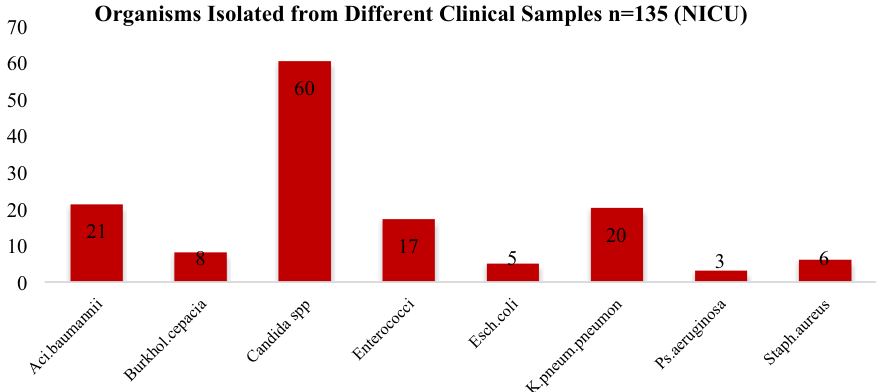
Figure 11. Spectrum of microorganisms isolated from clinical sample: Blood sample from NICU. Most common species identified from blood specimen of clinical samples shows the maximum presence of Candida spp. (60/135) followed by Acinetobacter baumanii (21/135), Klebsiella Pneumoniae (20/135) , Enterococci (12/135), Burkholderia cepacia complex (8/135), Staphylococcus aureus (6/135), E.coli (5/135), Pseudomonas aeruginosa (3/135).